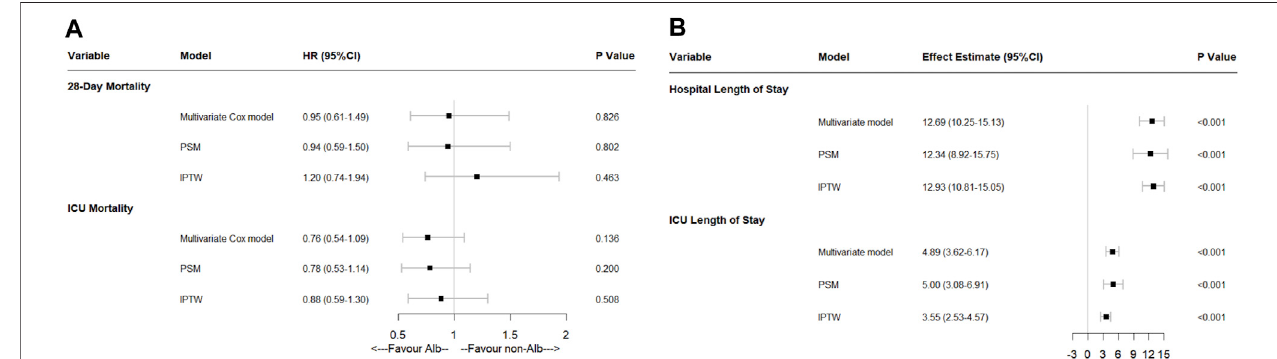
FIGURE 4 | Effect of human serum albumin infusion on secondary outcomes in acute pancreatitis patients from the MIMIC-IV database before and after matching through multivariate analyses. (A) Effect of human serum albumin infusion on 28-days mortality and ICU mortality in acute pancreatitis patients from the MIMIC-IV database before and after matching through multivariate Cox regressions. (B) Effect of human serum albumin infusion on hospital and ICU length of stays in acute pancreatitispatientsfromtheMIMIC-IVdatabasebeforeandaftermatchingthroughmultivariatelinearregressions.HR,hazardratio;ICU,intensivecareunit;PSM, propensity score matching; IPTW, inverse probability of treatment